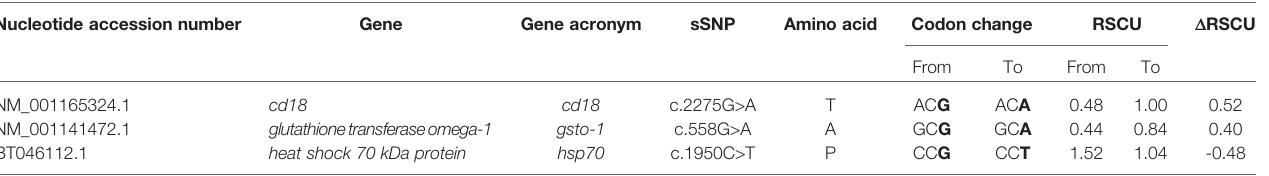
Bold letter represents the nucleotide variations in codon for each synonymous single-nucleotide polymorphism (sSNP). RSCU and D RSCU values were calculated ( D RSCU = RSCU mutant - RSCU wild type).